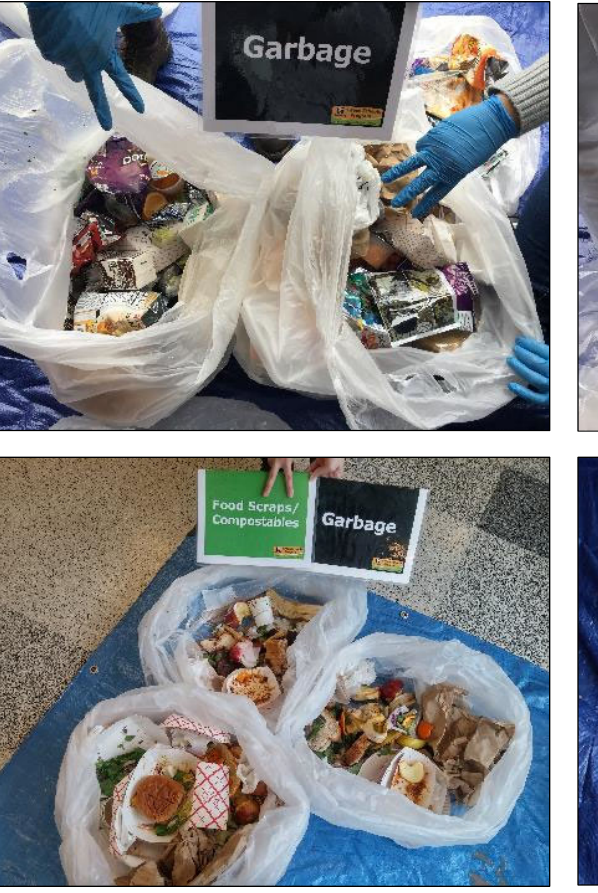
Figure 1. Top left: Garbage bags from lunchroom bins, prior to audit teams’ sorting.; Top right: Audit teams separate every piece of waste per its classification as trash, recycling, or compost.; Bottom left: Post-sort compost items that were sorted out of pre-sort trash bags.; Bottom right: Rescuable food items found following sorting of all trash, recycling, and compost